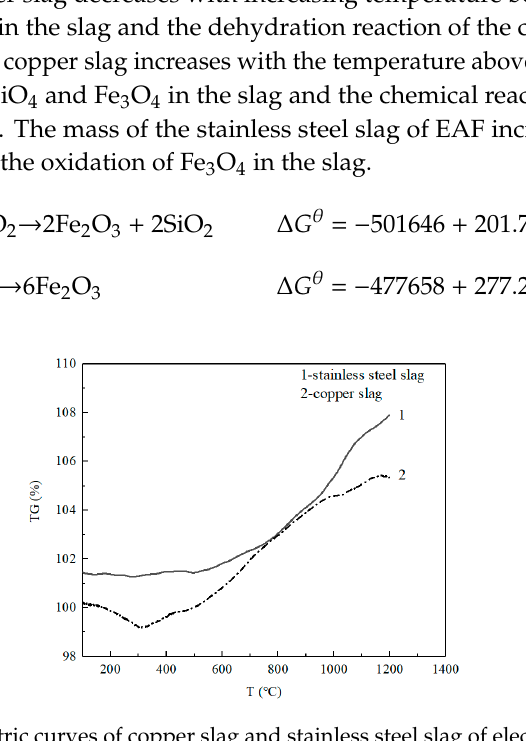
Figure 2. Thermogravimetric curves of copper slag and stainless steel slag of electric arc furnace (EAF).